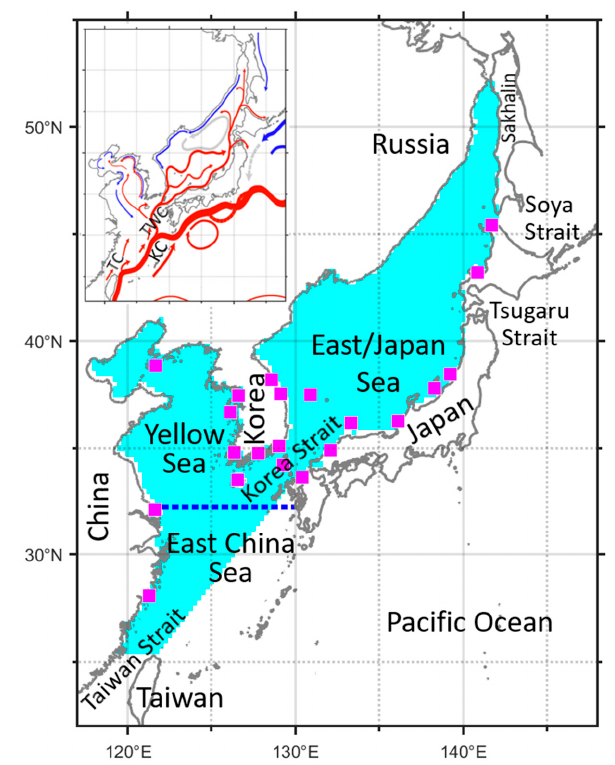
Figure 1. Domain of the northeast Asian marginal seas (NEAMS, cyan) and locations of twenty-one tide-gauge stations (magenta squares, available from https: // www.psmsl.org). The blue dotted line along the 32.25 ◦ N between China and Japan is for meridional Ekman transports. Schematics of the regional circulation patterns, with major surfaces (red or blue) and intermediate (grey) currents transporting warm (red) and cold (blue) waters in the upper left box (available from http: // www.khoa.go.kr). The stronger currents are shown with thicker arrows, while continuous and continual currents are indicated by solid and dashed arrows, respectively. KC, TC, and TWC are the Kuroshio Current, and the Taiwan and the Tsushima Warm Currents, respectively.